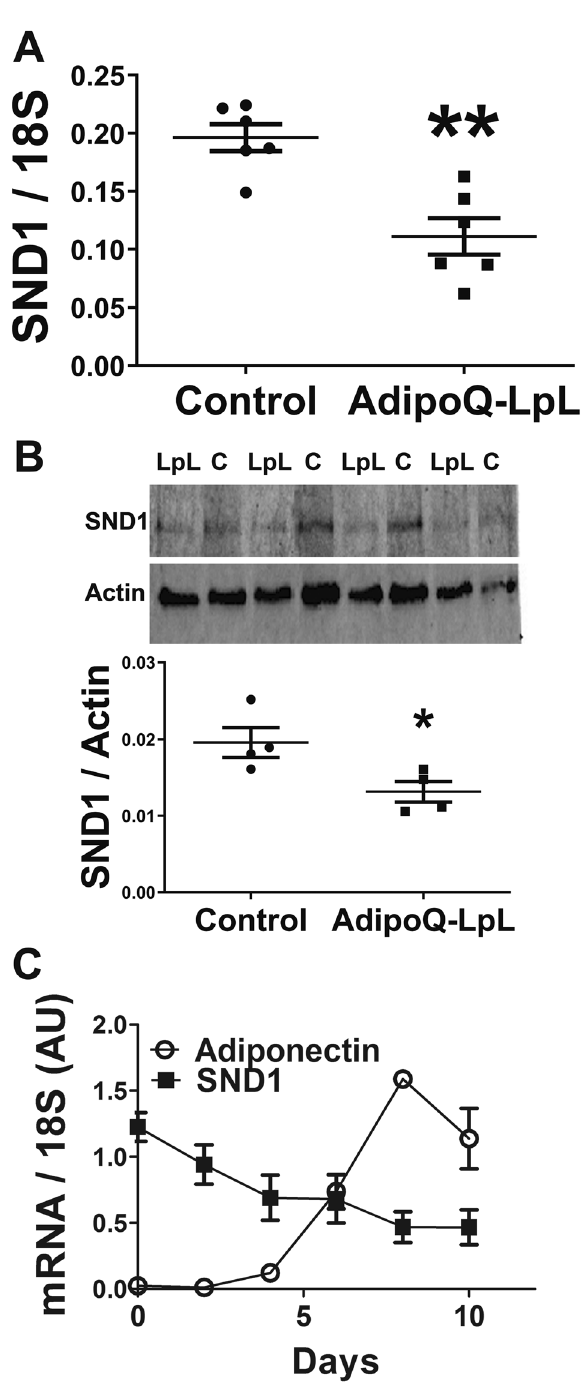
Figure 4. SND1 mRNA and protein expression in adipocytes. ( A ) SND1 mRNA expression was measured in the floating adipocytes obtained by collagenase digestion of adipose tissue from control and AdipoQ-LPL mice high fat diet (10-days). The data are represented as the mean ± SEM (n = 6; **P < 0.01; two-tailed unpaired Student’s t-test). ( B ) SND1 and actin were immunoblotted in lysates of floating adipocytes from control ( C ) and AdipoQ-LPL (LpL) mice on the high fat diet (10-days). The ratio of SND1 to actin was calculated, and the data are represented as the mean ± SEM (n = 4; *P < 0.05; two-tailed unpaired Student’s t-test). ( C ) Snd1 or AdipoQ mRNA expression during a time course of 3T3-L1 adipocyte differentiation (n =